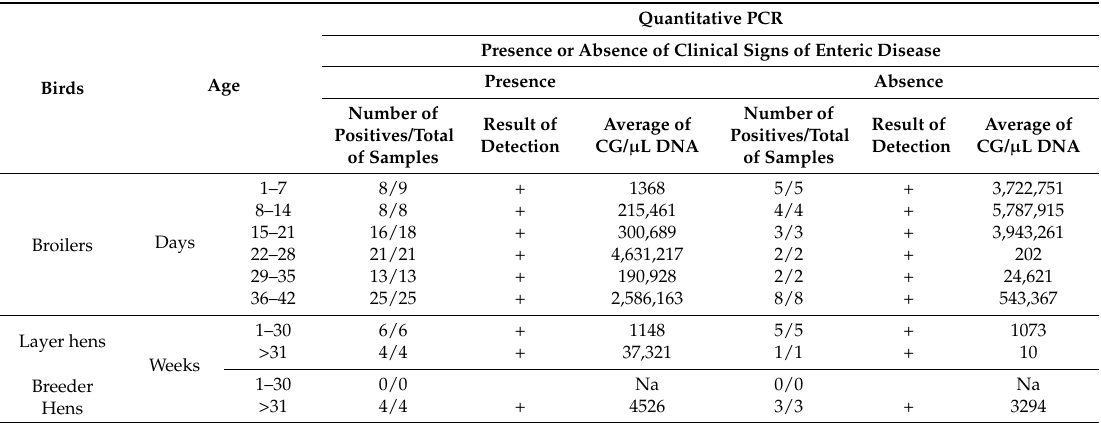
Table 2. Detection and quantification of Chicken Parvovirus (ChPV) in enteric contents from chickens with or without clinical signs of Runting-Stunting Syndrome